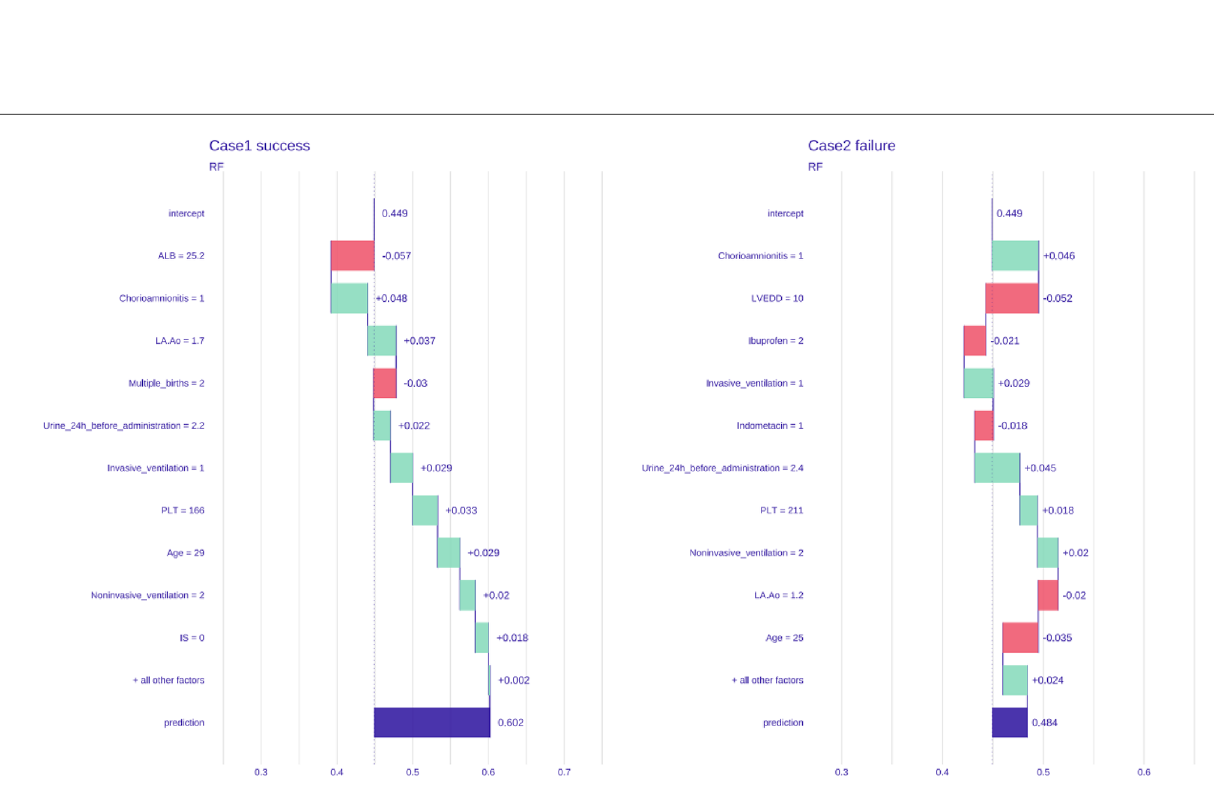
FIGURE 5 External prediction of treatment outcome of two premature infants.